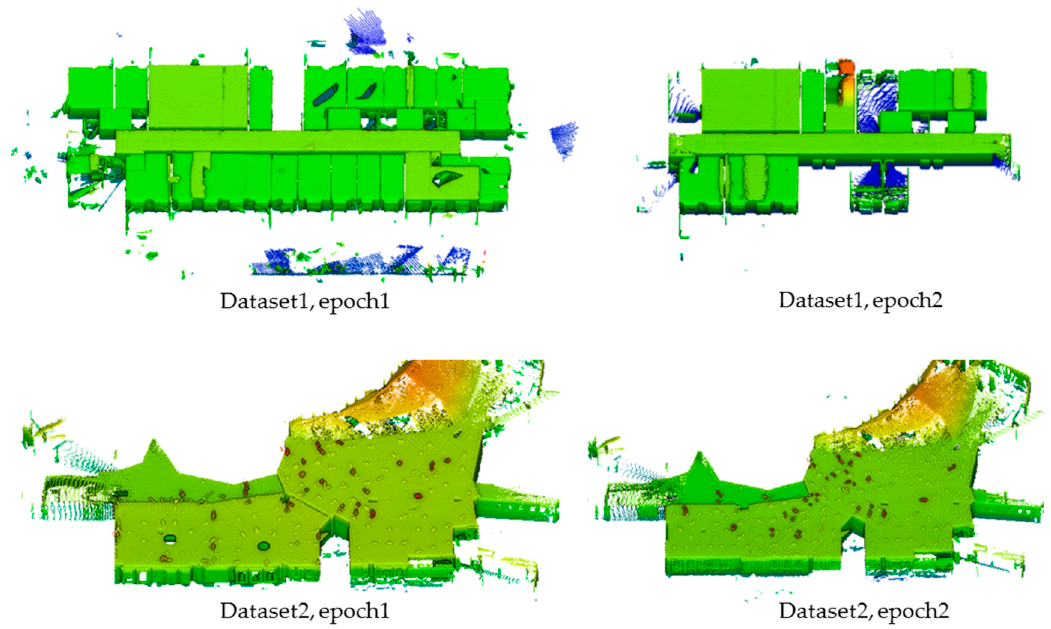
Figure 4. The floor plans for our two case studies. ( a ) ( top ) TU Braunschweig after the change (floor2), ( b ) ( bottom ) University of Twente ITC building (floor 1) before the change. The highlighted areas show the rooms where the changes happened.